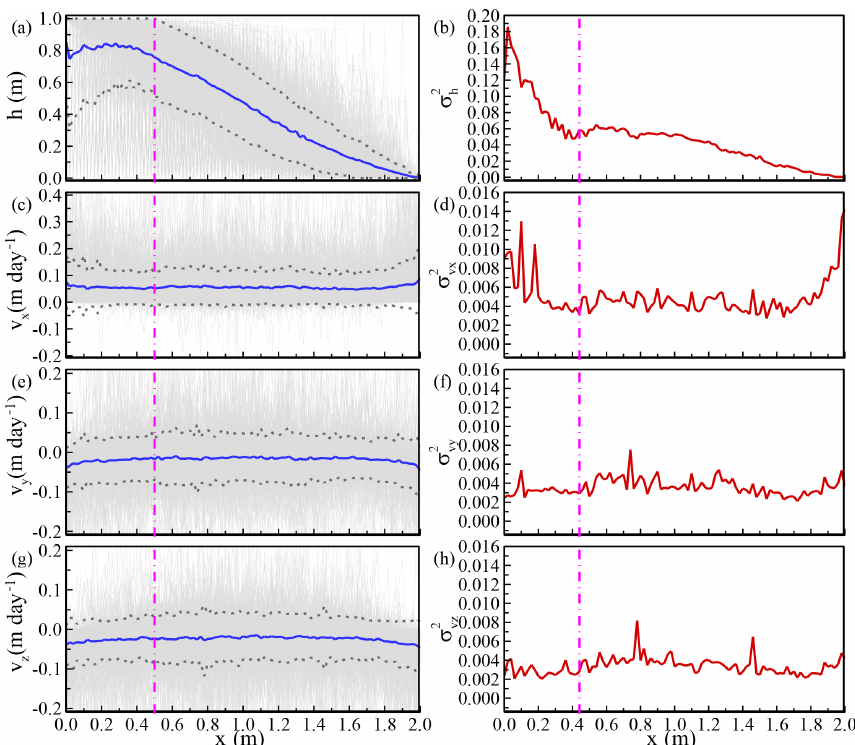
Figure 12. Comparison of flow uncertainties for vertical profile along the flow direction. (a) , (c) , (e) , and (g) represent the distributions of mean head and Darcy velocity and the associated SD about the means. (b) , (d) , (f) , and (h) represent the distributions of the head and velocity variances along flow direction. Note that the results were based on the vertical averaged head and Darcy velocities at each x location along the y = 1 . 0m profile. For each x location, the sampling volume was the same as the size of the specified sampling